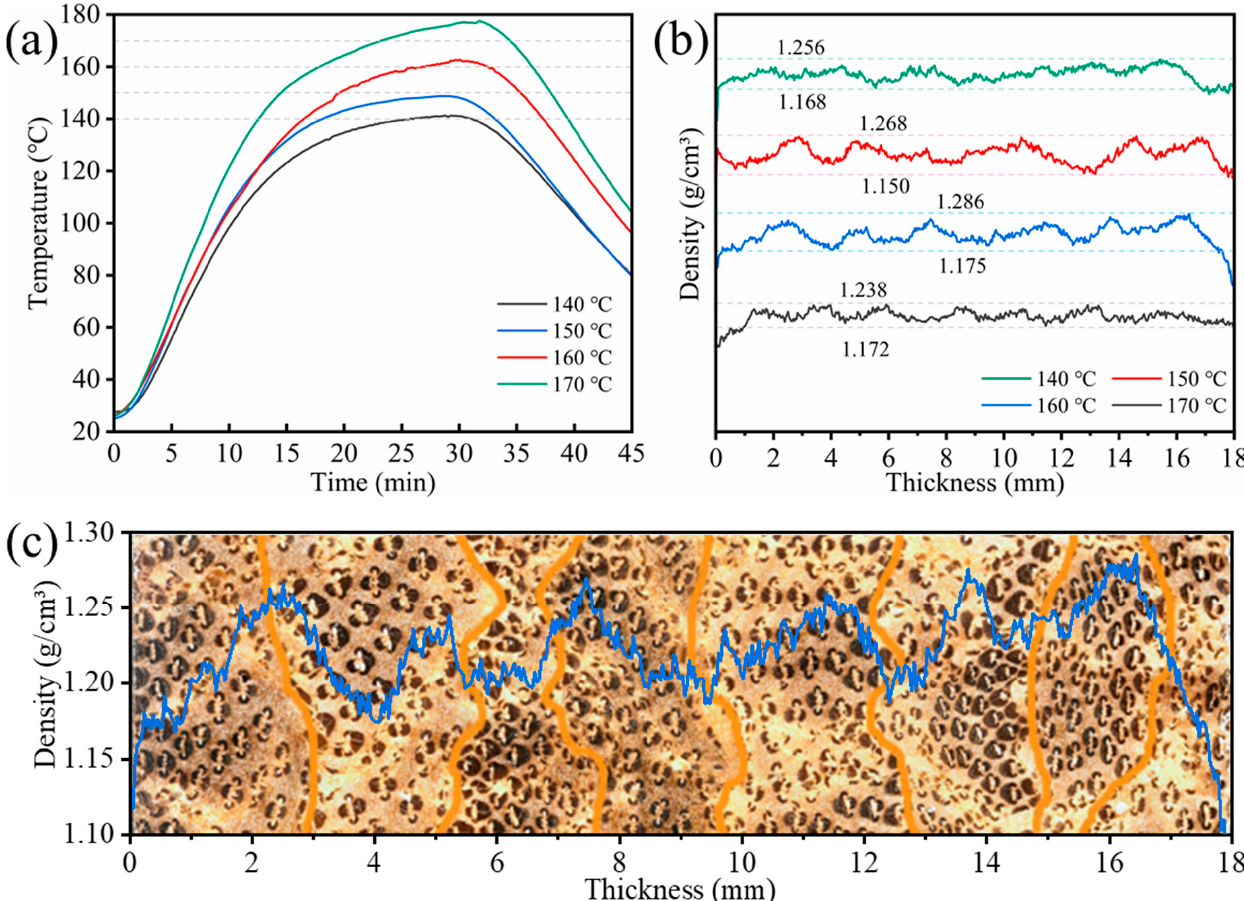
Figure 6. ( a ) Time–temperature curves of the inner layer during thermo-mechanical densification. ( b ) Density profiles of bamboo scrimber at different temperatures. ( c ) Schematic of the vertical density pro fi le variations during mat formation of bamboo scrimber.